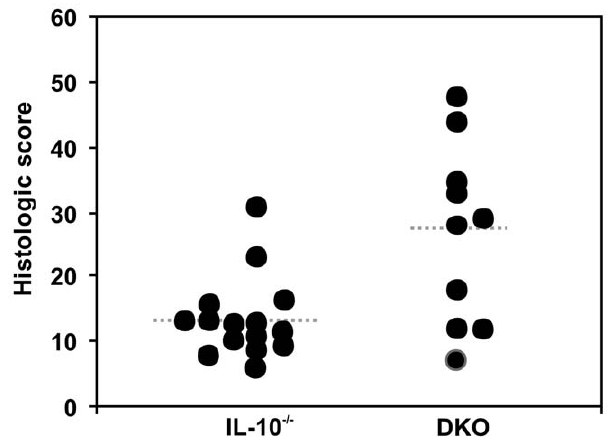
Figure 7. Severity of spontaneous IBD in specific pathogen- free Il10 2 / 2 and DKO mice. Il10 2 / 2 mice on the C57BL/6 background rarely developed spontaneous colitis by 36 weeks of age when housed under clean conditions, free from specific pathogens including Helicobacter spp. (mean histologic scores 6 SEM=13 6 2; n=15). In contrast, DKO mice that lacked mast cells frequently developed spontaneous colitis (mean histologic scores=27 6 4; n=10; p =0.02), which was evident at an earlier age (31 6 2 wks vs. 36 6 1 wks; p=0.02) compared with Il10 2 / 2 mice.